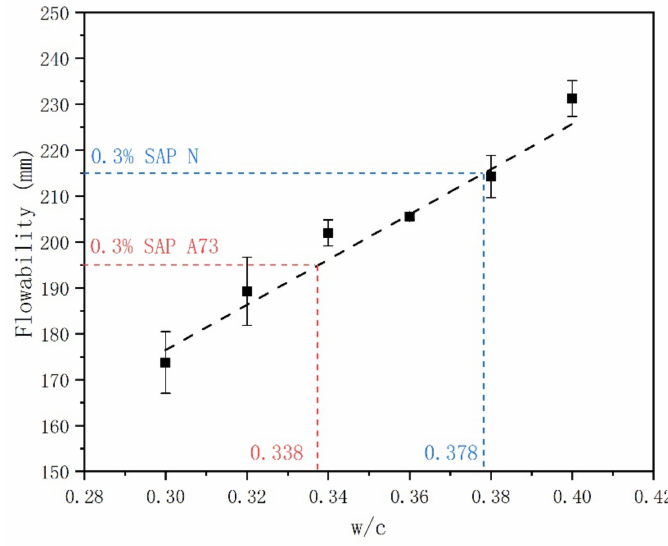
Figure 7. Relationship between w / c and